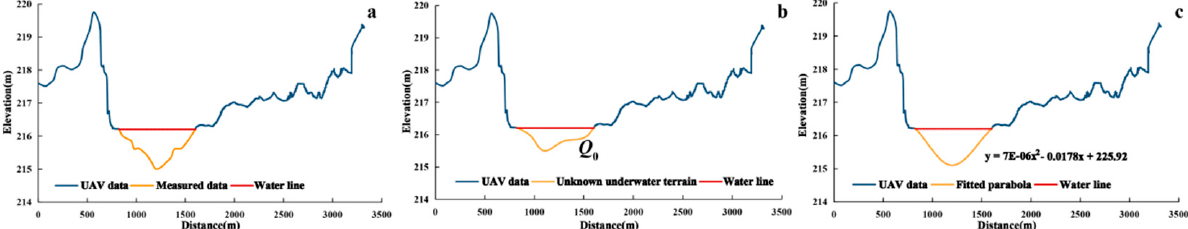
Figure 15. Underwater section acquisition method. ( a ): Supplement the missing underwater terrain data with measured data; ( b ): Estimate river flow based on background values; ( c ): Fit underwater terrain.